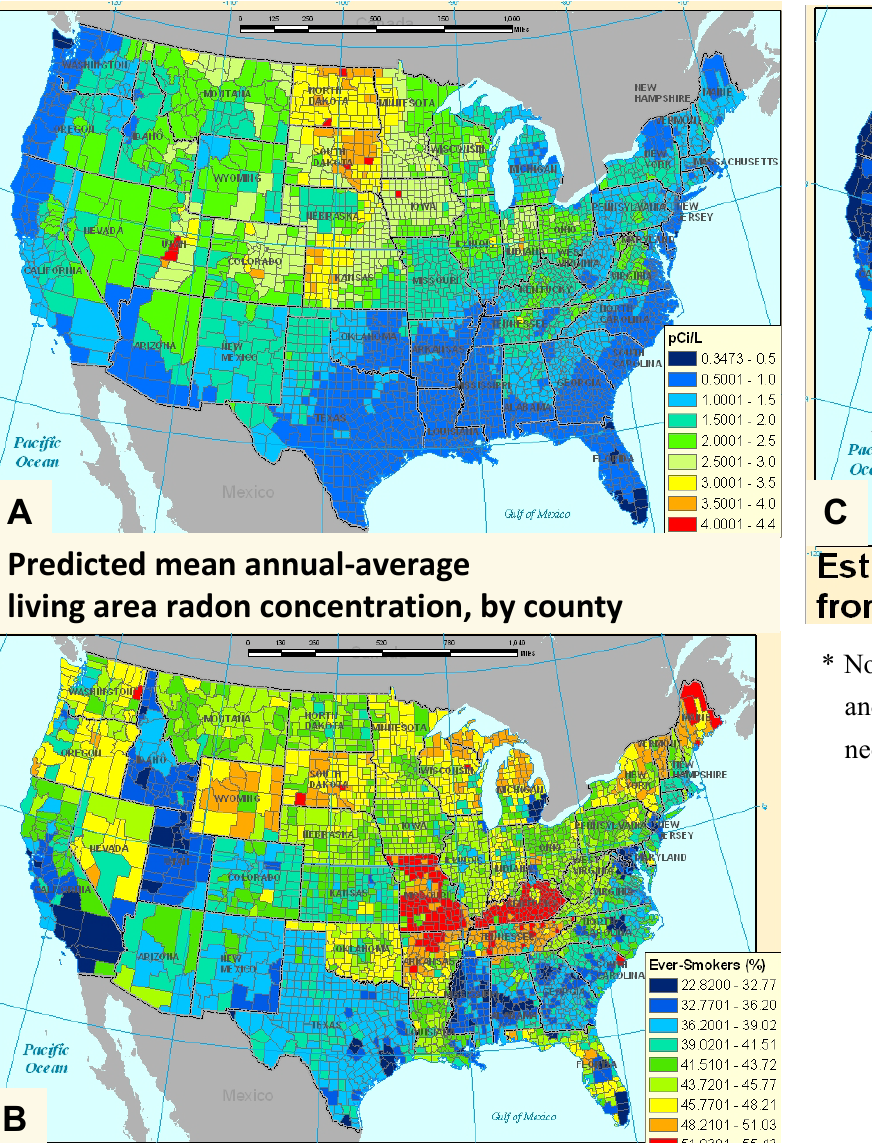
Figure 1. ( a ) Spatial patterns of county-average radon concentration, ( b ) Smoking, and ( c ) Lung cancer risk associated with radon.*